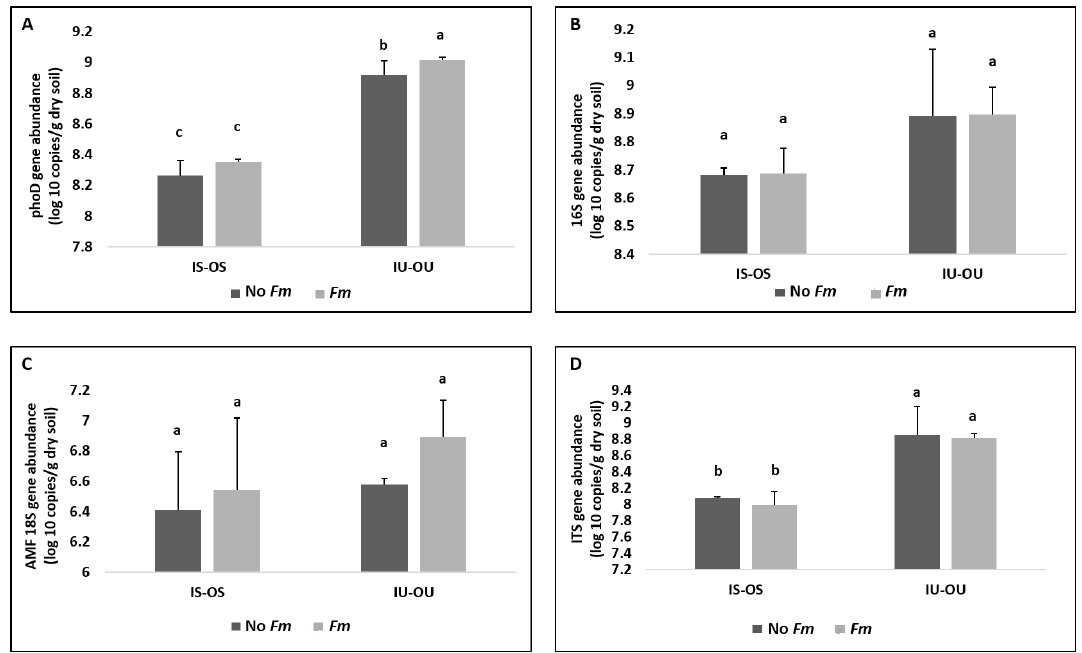
Figure 3. Abundances of targeted genes in hyphosphere soil. ( A ): phoD gene. ( B ):16S rRNA gene. ( C ): AMF 18S rRNA. ( D ): fungal ITS. IS-OS: soil in inner (hyphosphere) and outer (rhizosphere) compartments sterilized; IU-OU: both soils unsterilized. “ Fm ”: inoculated with Funneliformis mosseae . Data presented are mean with ± standard deviation ( n = 3). Different letters above the bars indicate significant difference between the treatments ( p < 0.05).